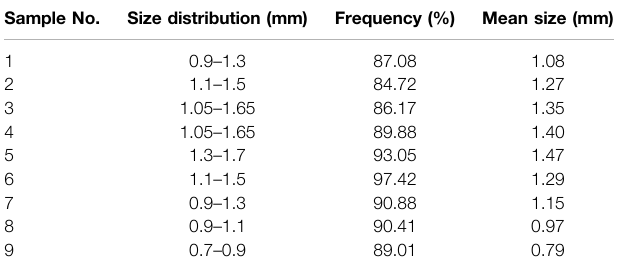
TABLE 2 | Size distribution of PS/Fe 3 O 4 composite beads. Sample No.